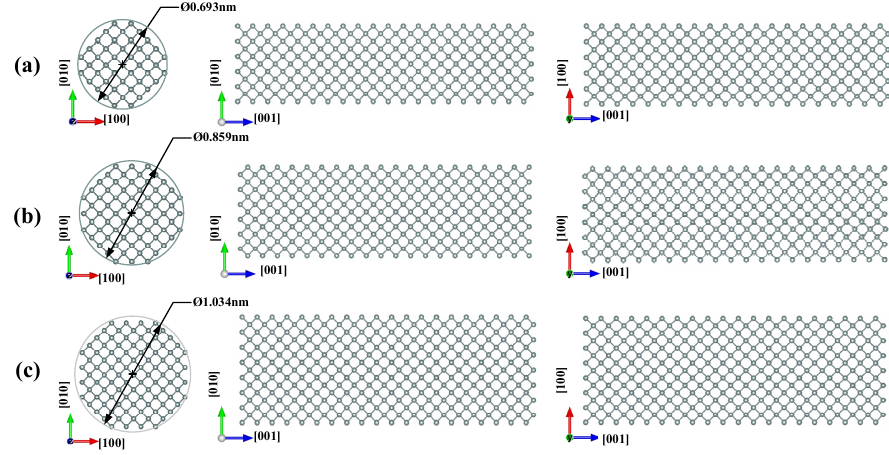
Figure 1. Initially constructed Si NWs with diameters of ( a ) SiNW1: 0.693 nm, ( b ) SiNW2: 0.859 nm, ( c ) SiNW3: 1.034 nm.